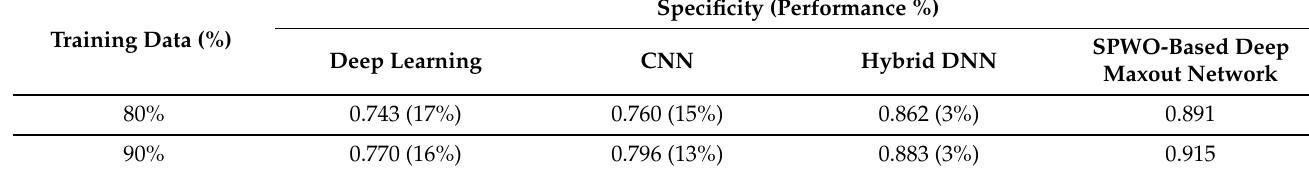
Table 5. Analysis with